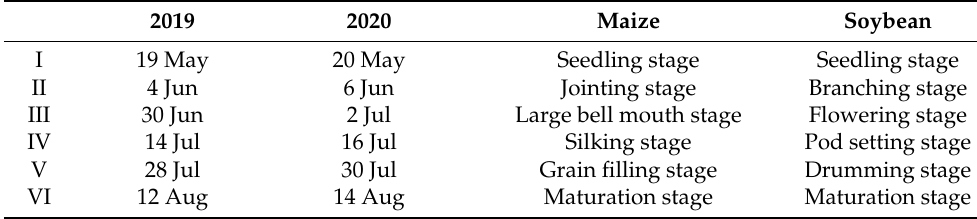
Table 1. Sampling time and corresponding crop growth stage.